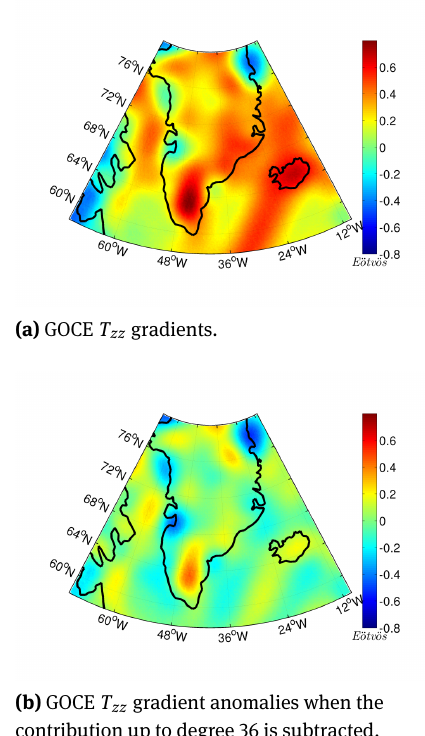
(b) GOCE T zz gradient anomalies when the contribution up to degree 36 is subtracted. Fig. 1. Reprocessed GOCE T zz gradients (a) and GOCE T zz gradient anomalies (b) when the contribution from Earth’s Gravitational Model 2008 (EGM2008) up to spherical harmonic degree and order 36 is subtracted. The dataset consists of data from November 2009 to June 2010. The given units are E ¨ o tv ¨ o s .